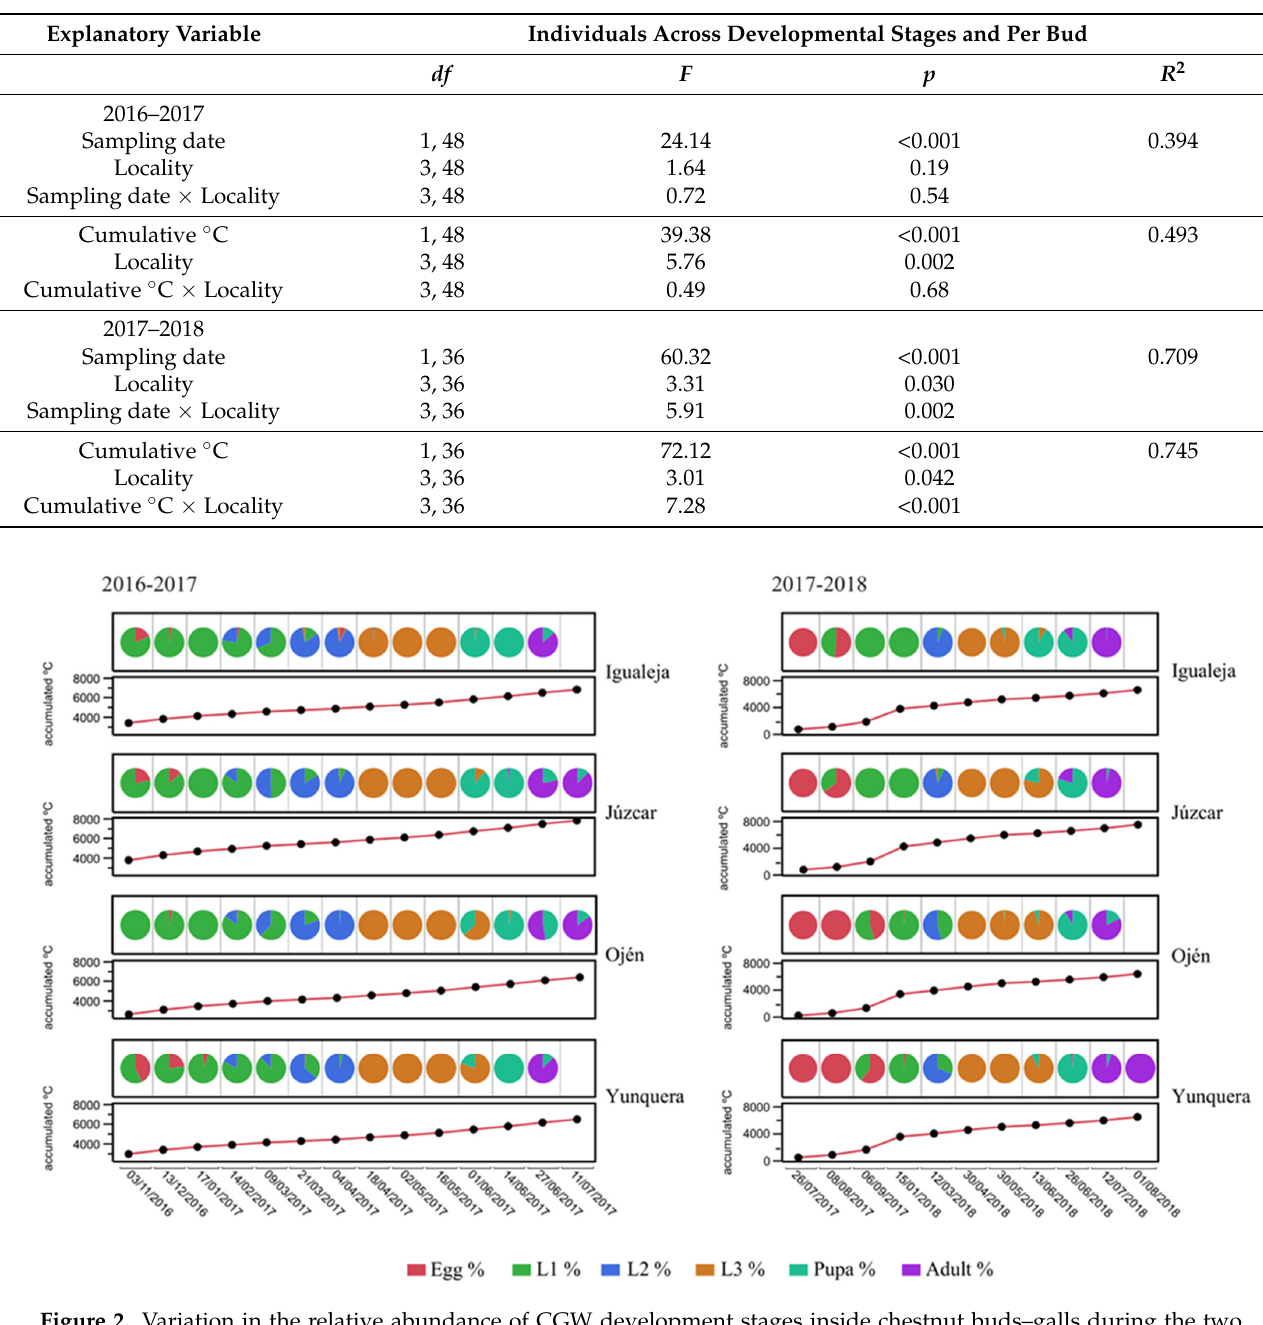
Figure 2. Variation in the relative abundance of CGW development stages inside chestnut buds–galls during the two assessed consecutive vegetative periods. Empty cells denote that all adults had already emerged from the galls. Below pie charts, the cumulative ◦ C in each of the samplings in each locality is